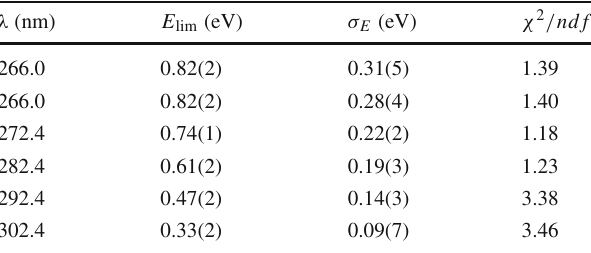
Fig. 7 Measured transmission functions and energy distributions with differentUVlightsources(laser:266nm,LEDs:275,285,295,305nm) at U ana = − 18 . 6kVand B + start = 27mT.Themeasurements( toppanel ) were performed at α p = 0 ◦ (zero angle). The given residuals are nor- malized to the respective uncertainties of the data points; the gray band here indicates the 1 σ -limit. In this setting, the transmission functions are dominated by the energy distribution of the emitted electrons ( lower panel ). The dashed lines indicate a second measurement at same set- tingsfor λ = 266nm.The cross-shapedmarkers intheenergyspectrum indicate the determined energy limit E lim and its uncertainty. Note that E = 0eV in the energy distribution corresponds to the upper edge of the transmission function, where the observed transmission functions reach their nominal amplitude Table 1 Measured transmission functions at different wavelengths λ and fixed spectrometer voltage U spec = − 18 . 6kV (Fig. 7). The table shows the upper limit of the energy distribution, E lim , and the energy spread, σ E ; both values are derived from the fit result. The measurement at 266nm has been performed twice at −